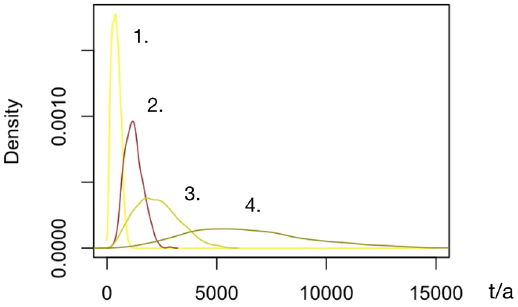
Figure 3. SiO 2 -ENM contributions in t/a ( x axis) to use release into wastewater in 2017 (most probable range). From left (mean contribution to total release): 1. colloidal silica (4%), 2. pyrogenic silica (12%), 3. gel silica (22%), and 4. precipitated silica (62%).